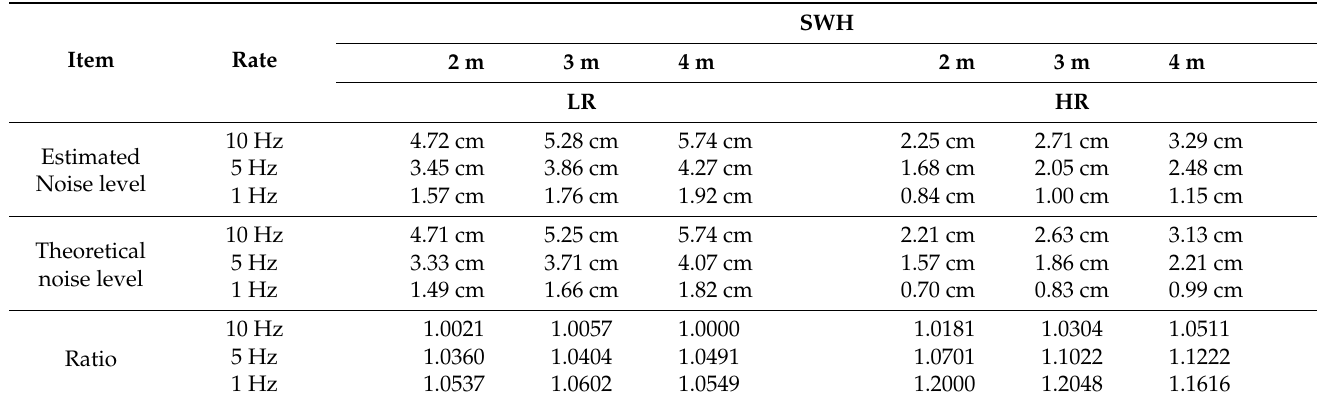
Table 5. The estimated and theoretical noise levels of re-processing data and their ratios.